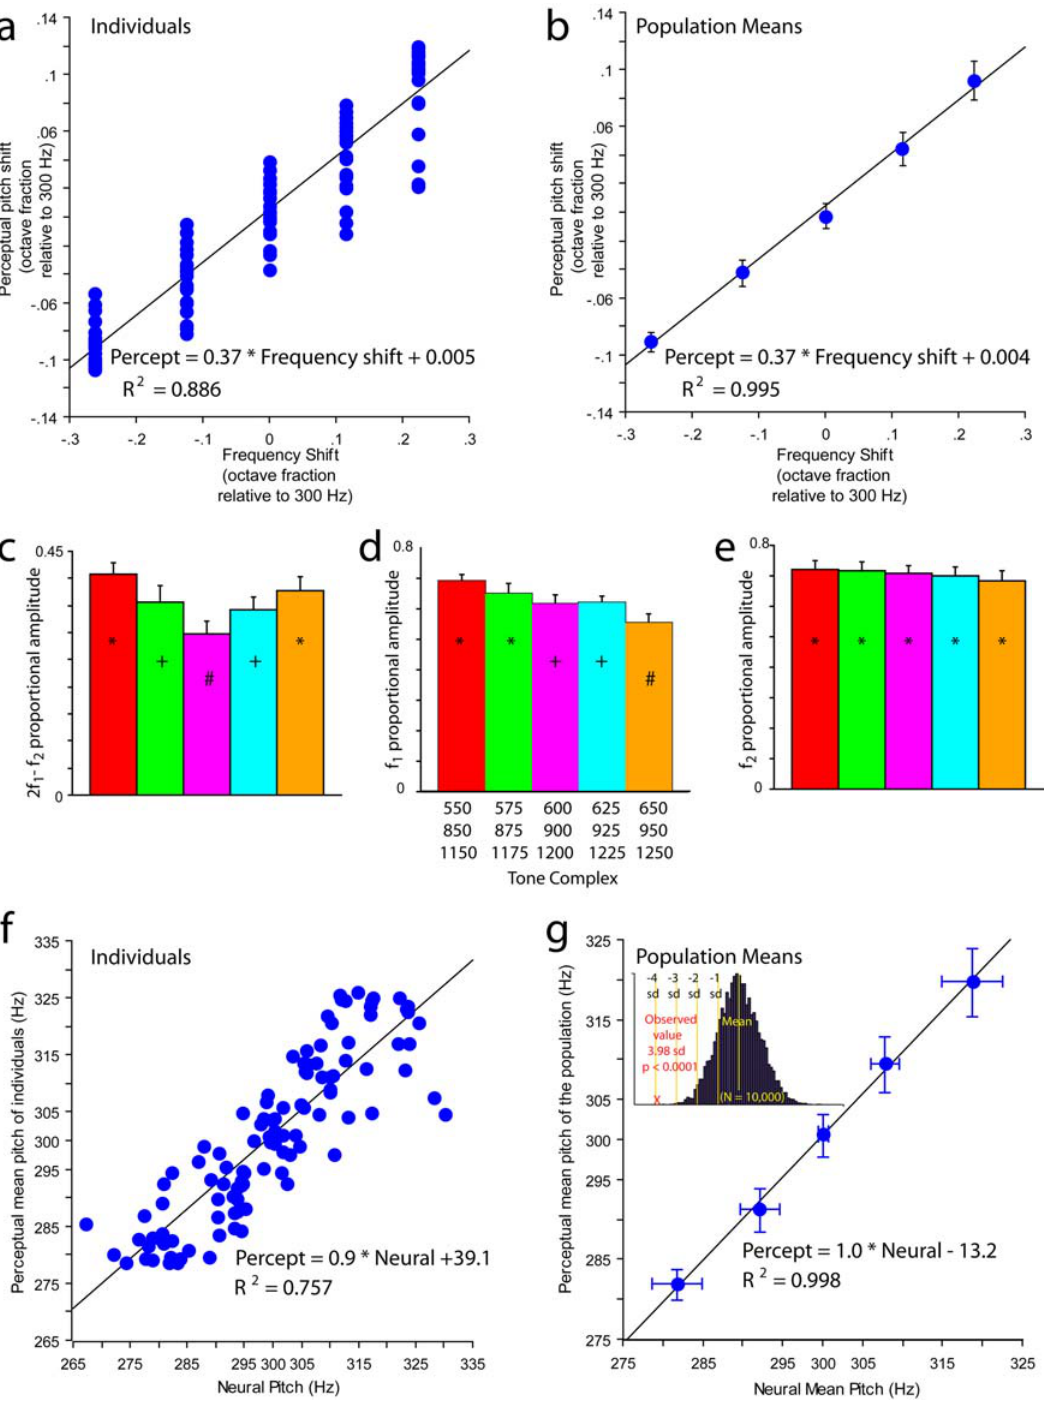
Figure 3. Pitch percepts and their relationship to evoked potential responses. (a) Mean pitch percept (10 repetitions) of each stimulus for each of 22 subjects plotted against the frequency shift of each stimulus; units are octave fractions relative to 300 Hz. The equation of the best-fitting regression line and the r 2 are also shown. (b) Population mean pitch percepts (22 subjects) plotted against the frequency shift of each stimulus, units as in (a). The error bars show 95% confidence intervals around the mean values. (c,d,e) The mean values (22 subjects) for the proportional amplitude of the difference waveform (fine-structure-phase-related) spectral peaks for the 5 stimuli. The error bars show 1 standard error around the mean values. Bars containing the same symbol are not significantly different from each other; bars containing different symbols are significantly different from each other (see Methods). Colors refer to Figure 2a. (f) Mean pitch percept of each stimulus for each of 22 subjects plotted against their own neural pitch estimates. The equation of the best-fitting regression line and the r 2 are also shown. (g) Population mean pitch percepts (22 subjects) plotted against the population mean neural pitch estimate. The error bars show 95% confidence intervals around the mean values for each axis. (Inset) The frequency distribution of distances of population neural pitch estimates from the population pitch percept according to a random model (black) compared with the distance obtained in this study (red cross), showing that the present results are highly unlikely to be obtained by chance (see Methods).